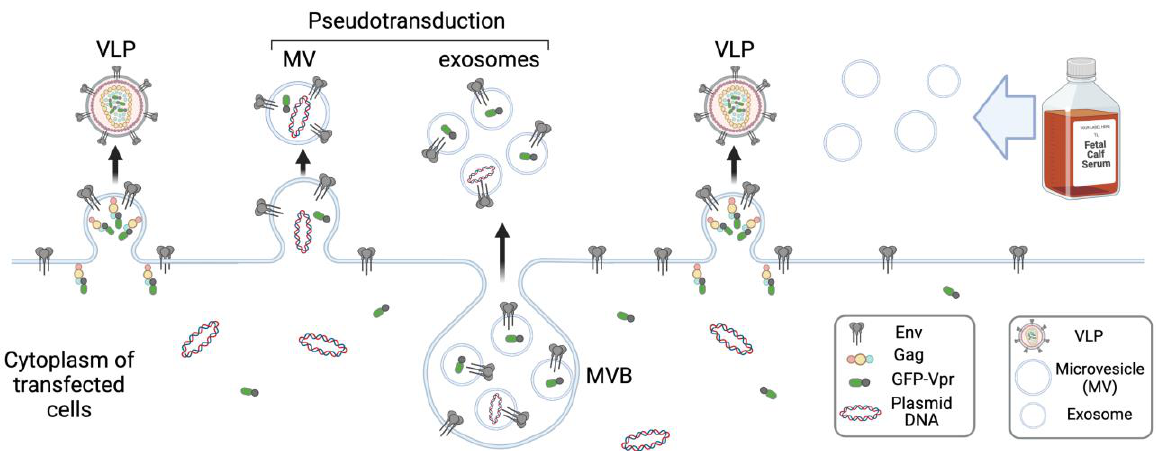
Figure 3. Contamination of VLPs with EVs and pseudotransduction. Transfected VLP-producing cells secrete MVs from the plasma membrane and exosomes as a result of MVB fusion with the plasma membrane. Once EVs are pseudotyped with Env, for example, VSVG, and spontaneously loaded with cargo protein, they can transduce (pseudotransduce) target cells along with VLPs. Created with https://app.biorender.com/illustrations/638a443e9cc25bb34b5c8f23 (accessed on 2 March 2023).